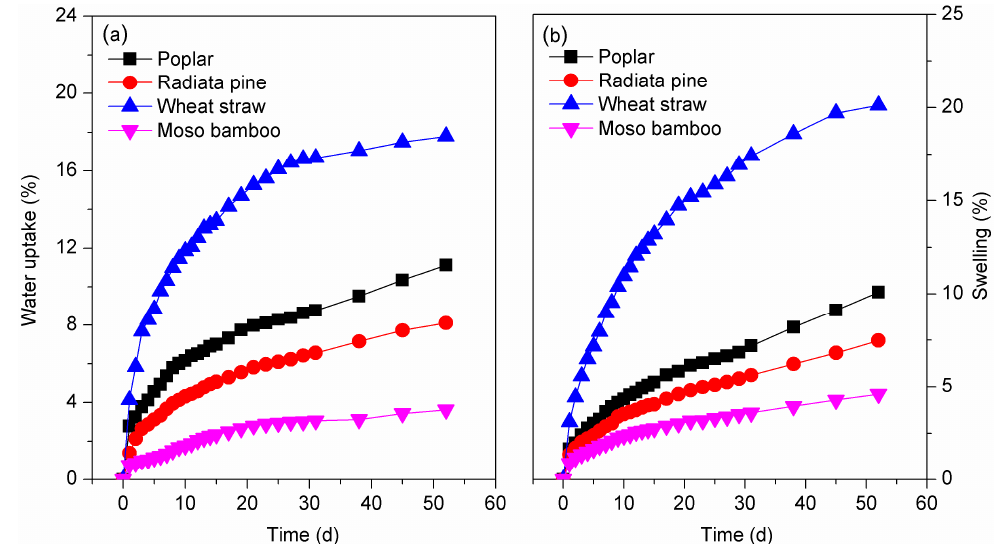
Figure 6. ( a ) Water absorption and ( b ) thickness swelling of the composites.